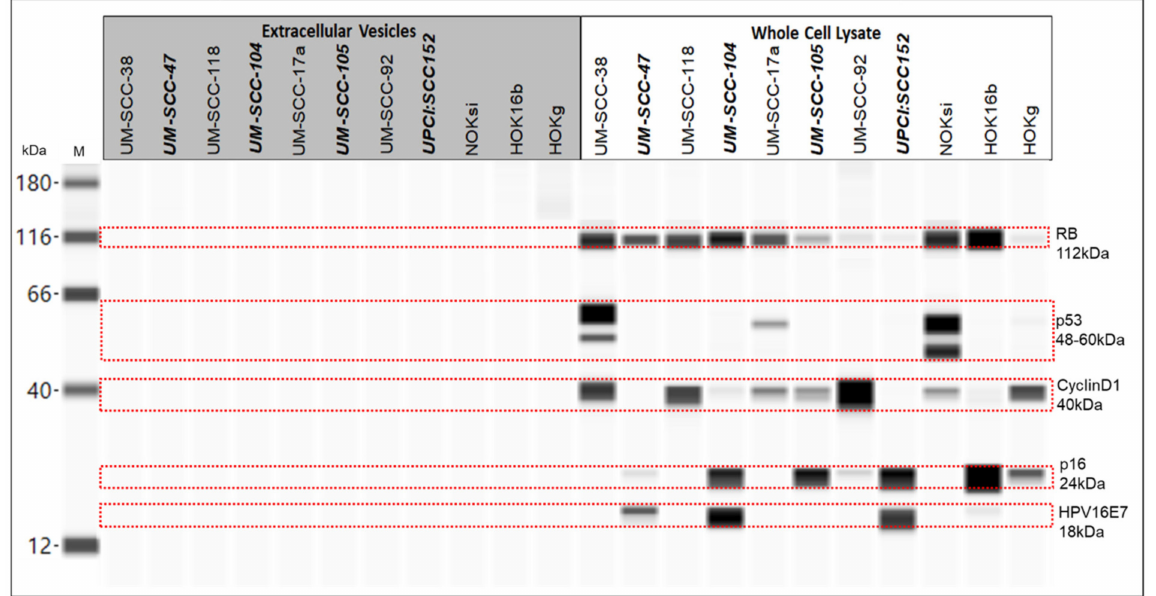
Figure 8. Wes protein gel for extracellular vesicles and whole cell lysates from HNSCC, normal keratinocyte, and trans- formed cell lines. RB detected at 112 kDa, 1:100 antibody dilution, 0.5 mg/mL protein; p53 detected at 60 kDa, 52 kda, and 48 kDa, 1:50 antibody dilution, 0.25 µ g/ µ L protein; CyclinD1 detected at 40 kDa, 1:200 antibody dilution, 0.25 µ g/ µ L protein; p16 detected at 24 kDa, no antibody dilution, 0.25 µ g/ µ L protein; and HPV16E7 detected at 18 kDa, 1:100 antibody dilution, 1 µ g/ µ L protein. Bold italics: